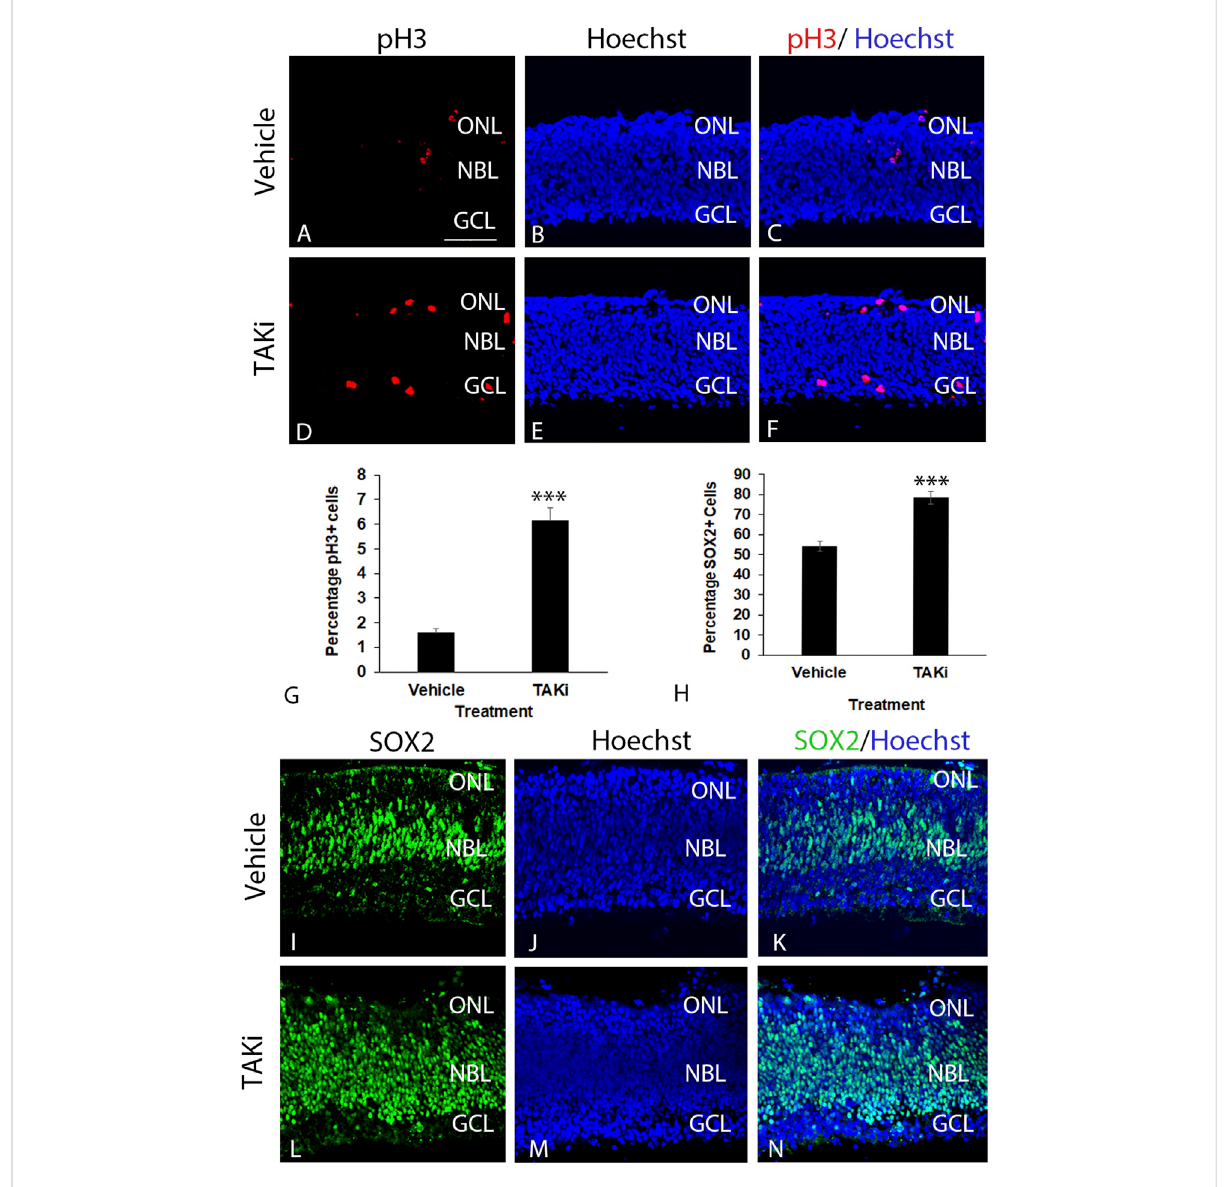
Taki-treated retinas have an increase in pH3+ and SOX2+ retinal progenitors in comparison to vehicle-treated retinas. E6 chick retinal cultures were treated with vehicle or 2 μ m TAK1 inhibitor (Sanjo et al., 2019) for 24 h and sections through retinas were co-labeled for cell division marker phospho-histone 3 [pH3; (A,C,D,F) ] or progenitor marker SOX2 (I,K,L[N) and Hoechst dye for DNA [blue; (B,C,E,F,J,K,M,N) ]. Percentages of labeled cellswerequanti fi edin3separate retinasforpH3+cells (G) orSOX2+cells (H) .Standarddeviationisshownin (G,H) .A=50 μ mforimages( A – F and I – N ). Abbreviations: ONL, outer nuclear layer; NBL, neuroblast layer; GCL, ganglion cell layer. Scale bar in A = 50 μ m for images A – F and I – N